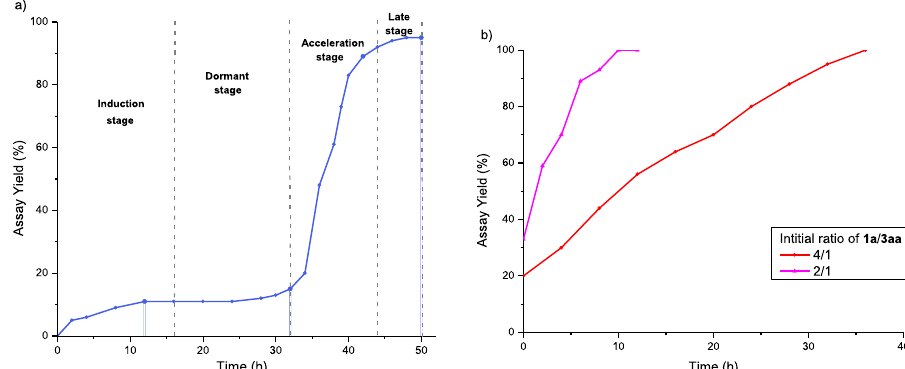
Fig. 3 Reaction pro fi les of copper-catalyzed photoredox Chan-Lam couplings. a Standard conditions. b Initiation in the presence of 3aa .